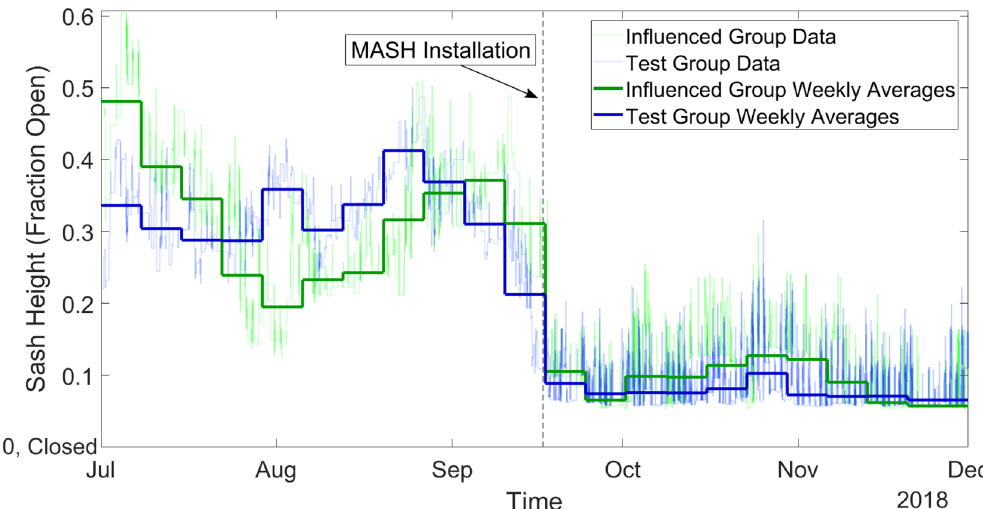
Figure 5. Test hoods versus influenced hoods. This figure shows the average sash heights of the test and influenced groups recorded every 15 min (lighter colored lines) and the weekly average sash heights of both groups (bold). The dashed line indicates when the MASH alarms were installed. Despite not having an alarm attached to the fume hood itself, having an alarm co-located in the lab caused the average sash height of the “influenced” hoods to decrease in a similar manner to the test group. This evidence shows that having an alarm near a hood, or having knowledge that the alarms are installed on other hoods in the lab, can cause lab users to operate their hoods in a more energy efficient manner. (A value of 0.07 or below is considered closed by the KGS clockworks